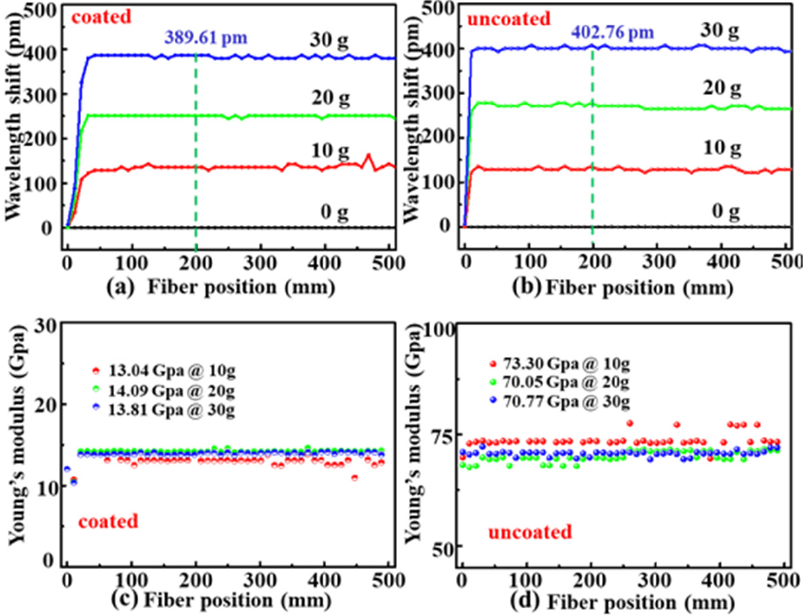
Figure 5. Wavelength shift evolution of the backscattering signal at the position from 0 to 500 mm along the axes of the ( a ) coated and ( b ) uncoated SMF samples while the weight applied was increased 10, 20, and 30 g. Calculated Young’s modulus distribution at each position of the ( c ) coated and ( d ) uncoated SMF samples.